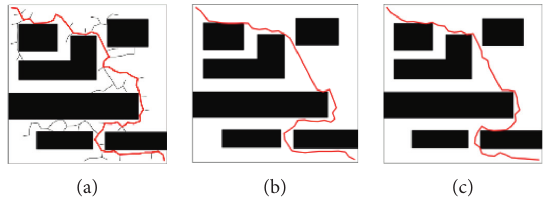
Figure 5: Map 2 running path diagram. (a) RRT. (b) ACO. (c) Ant colony optimization RRT.